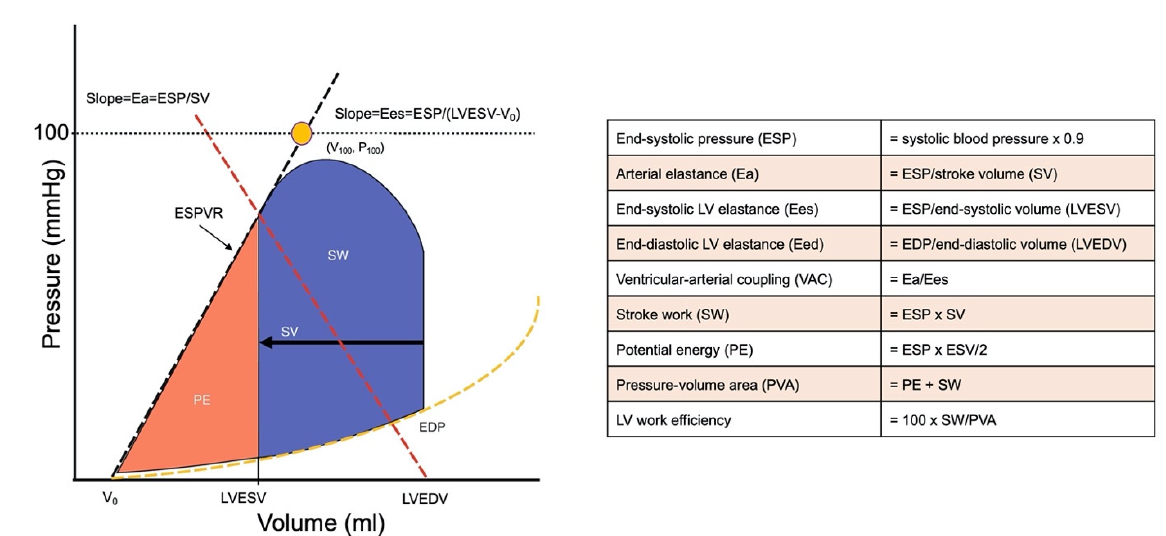
Figure 7. Pressure-volume loops of the left ventricle ( left ). Measurement of parameters derived from a pressure-volume loop of the left ventricle ( right ). End-systolic elastance (Ees) represents the slope of the end-systolic pressure volume relationship (ESPVR) where ESP denotes end-systolic pressure, and Ees represents the noninvasively derived single-beat estimation of this parameter. LVEDV is the end-diastolic volume, and LVESV is the end-systolic volume. V0 is the intercept of the ESPVR at an end-systolic pressure of 0 mm Hg, and V100 is the point on the end-systolic pressure volume line at an end-systolic pressure of 100 mm Hg. Effective arterial elastance (Ea) represents the negative slope joining the end-systolic pressure volume point to the point on the volume axis at end-diastole, where SV represents stroke